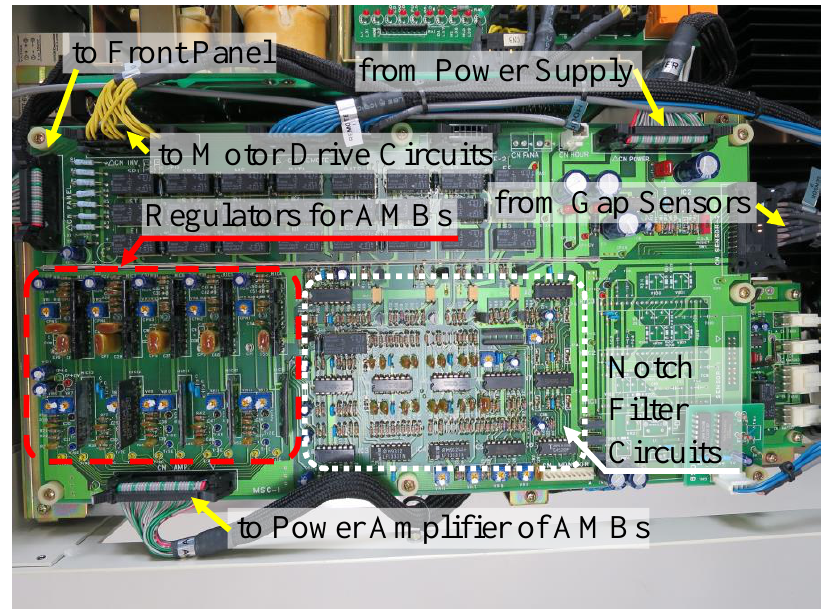
Figure 3. Internal view of ECU for TMP (Model: Osaka TD700/1100 ).